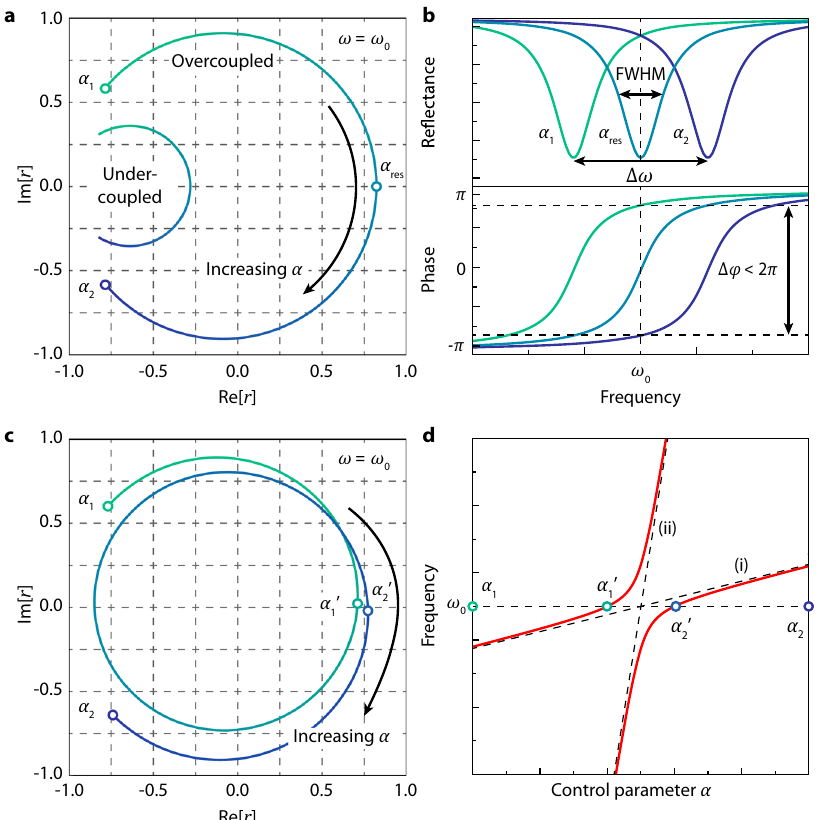
Fig. 1 Problems in dynamic phase modulation and the usage of avoided crossing as a solution. a The trajectories of the complex re fl ection coef fi cient for under-coupled and over-coupled resonances at the operating frequency ω 0 as the single control parameter α is varied (color change from green to blue). Over-coupling is critical for modulating phase with a large coverage, as well as maintaining uniform amplitude. Over-coupling alone however cannot close the 0 – 2 π loop. b The re fl ectance (top) and the phase (bottom) distributions of a single resonance as the control parameter is varied from α 1 through α res to α fi gure of merit Δ ω /FWHM (full width 2 . The trade-off due to the interdependence between the resonance shift and the spectral width results in a subpar at half maximum) insuf fi cient for a complete 0 – 2 π range. α res corresponds to the control parameter value that results in the resonance frequency coinciding with ω 0 . c The trajectory of the complex re fl ection coef fi cient when an avoided crossing is used. Use of an avoided crossing circumvents the trade-off issue, closes the phase loop and modulates phase with uniform amplitude with an upper bound of 4 π . d The mode dynamics of the avoided crossing. The original resonance frequencies without the avoided crossing are shown with dashed lines, where resonance (i) is over-coupled and spectrally narrow while resonance (ii) has high resonance frequency tunability. The resonance frequencies of the coupled modes after the avoided crossing occurs are shown with solid red lines. The horizontal dashed line represents the operating frequency ω 0 . α 1 ’ and α 2 ’ are the values of the control parameter where the frequency of the coupled resonances coincide with ω 0 therefore exhibiting fi nite avoided crossing as exempli fi ed in Fig. 1d. From the previous analysis, it is evident that spectrally narrow modes tend to have a large mode volume and therefore generally have small resonance shifts (small numerator over a large denominator in both Eqs. 1 and 2), while highly tunable modes tend to be spectrally broad. When coupled, the avoided crossing will then serve to hybridize the resonances, resulting in two modes with the combined features of being over-coupled and spectrally narrow, and having a large resonance shift. This grants three effects. First, the modes momentarily gain a superior 4 ω = FWHM as the avoidance between two modes provides an extra frequency shift, which is unavailable to conventional modes susceptible to the trade-off. Second, if the original spectrally narrow resonances were highly over-coupled, the hybrid modes would still be highly over-coupled near the uniform amplitude as shown in Fig. 1c. Finally, because these modes sweep across the operating frequency subsequently one